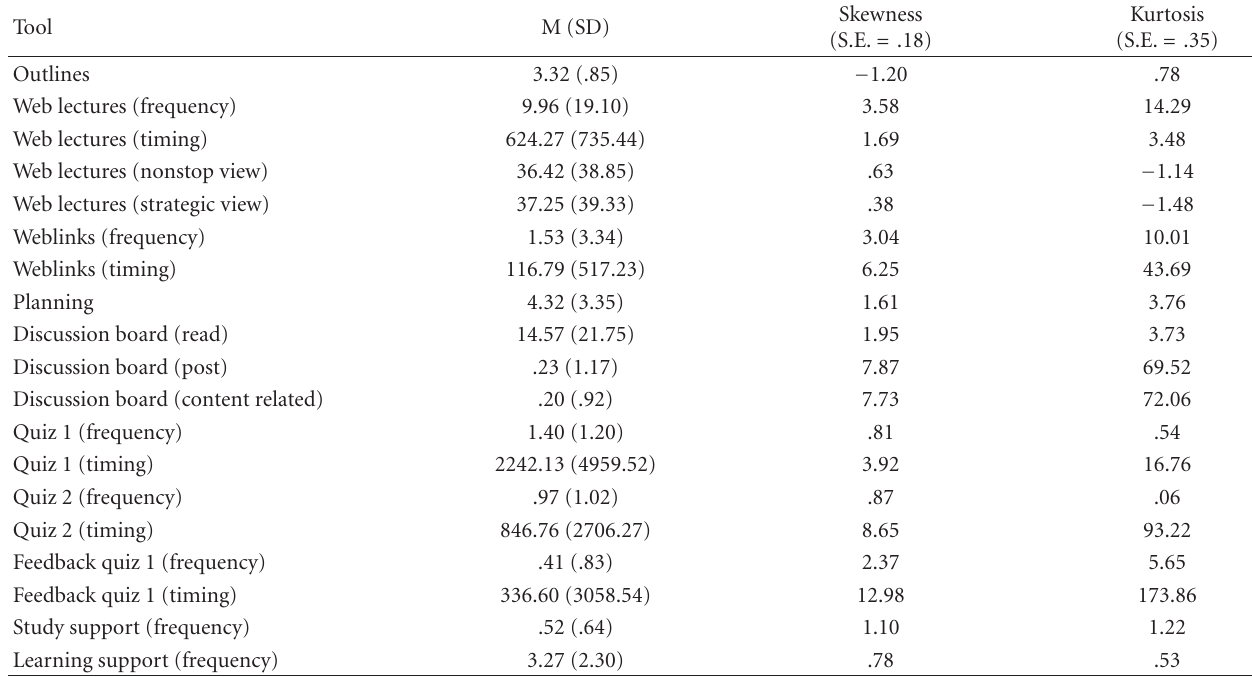
Table 4: Tool use descriptive.